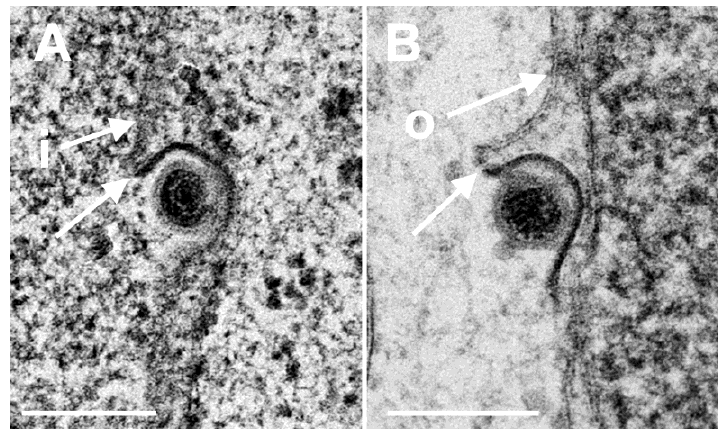
Figure 5. TEM images of budding capsids ( A ) at the INM (i) and ( B ) at the ONM (o). Note the identity of the two phenotypes, the ridge (arrows) formed on one side at each particle, and the eccentricity of the process. Ridges and eccentricity are not consistent with fusion. Bars 200